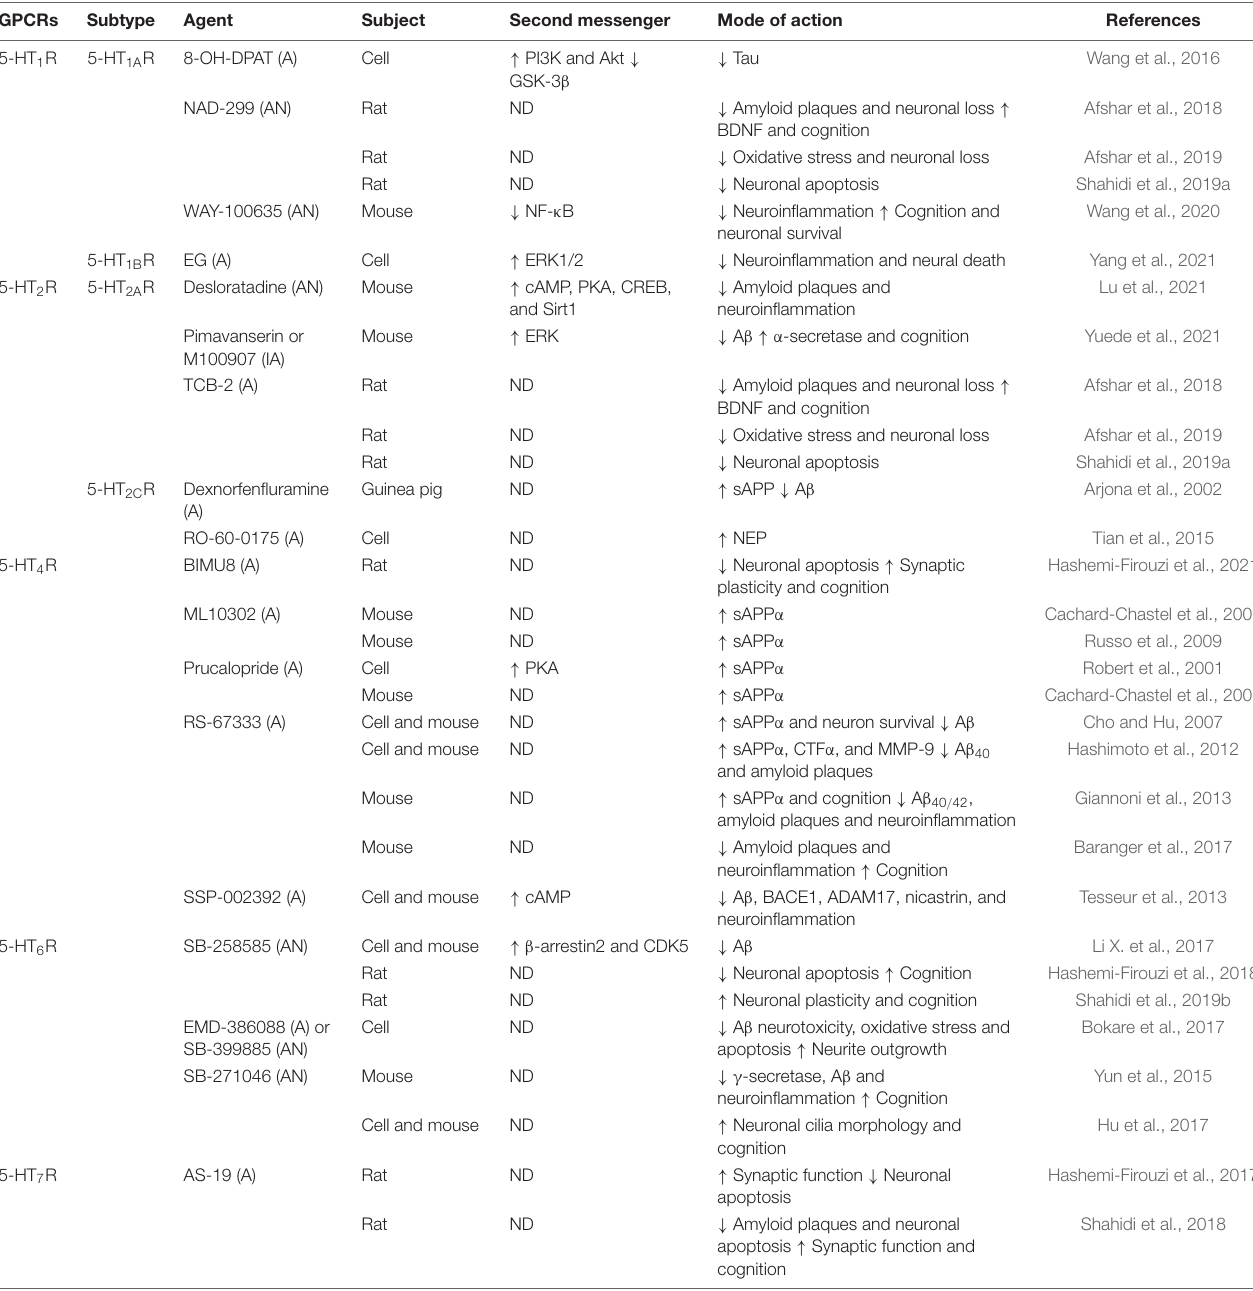
TABLE 3 | Serotonergic receptors reported to be involved in Alzheimer’s